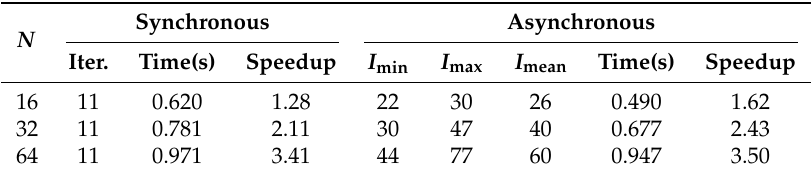
Table 2. Comparison of Synchronous and Asynchronous Parareal Scheme, given m = 150, S = 25, E = 30, δ t = 0.001, ∆ T =